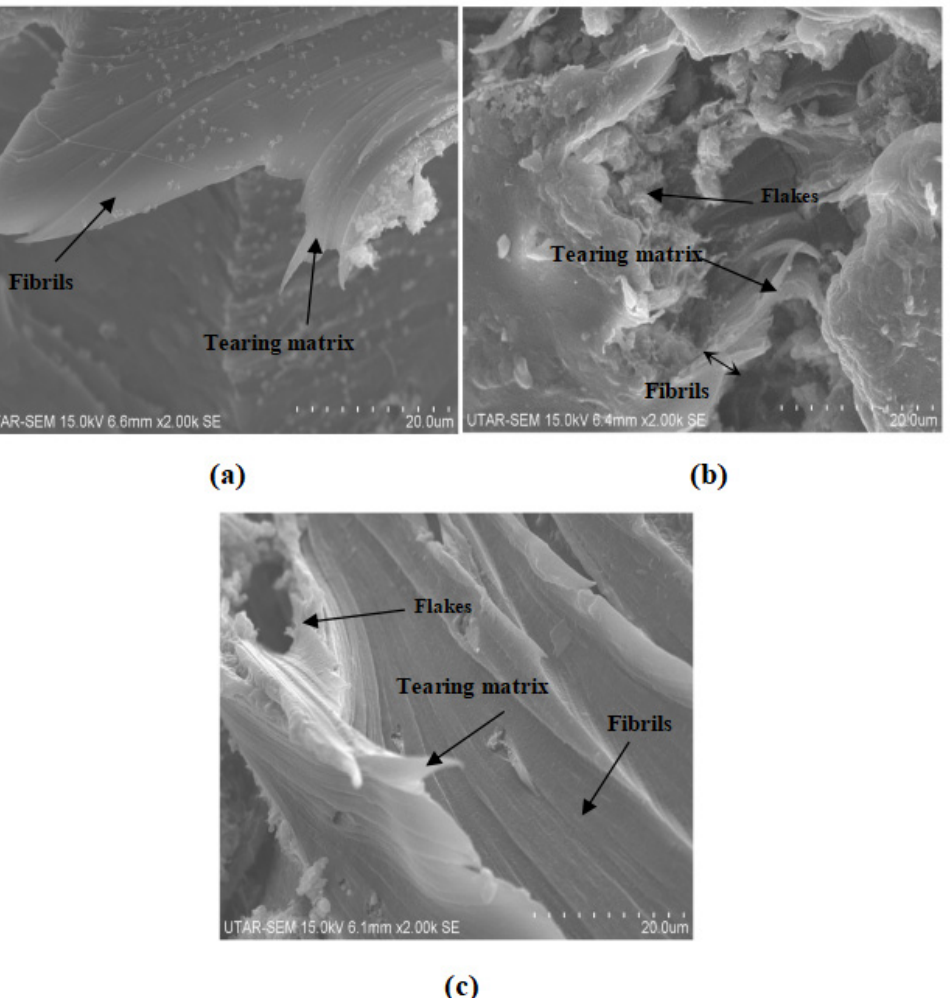
Figure 9. SEM micrograph of 2 phr calcined cuttlebone incorporated into PVOH matrix added with